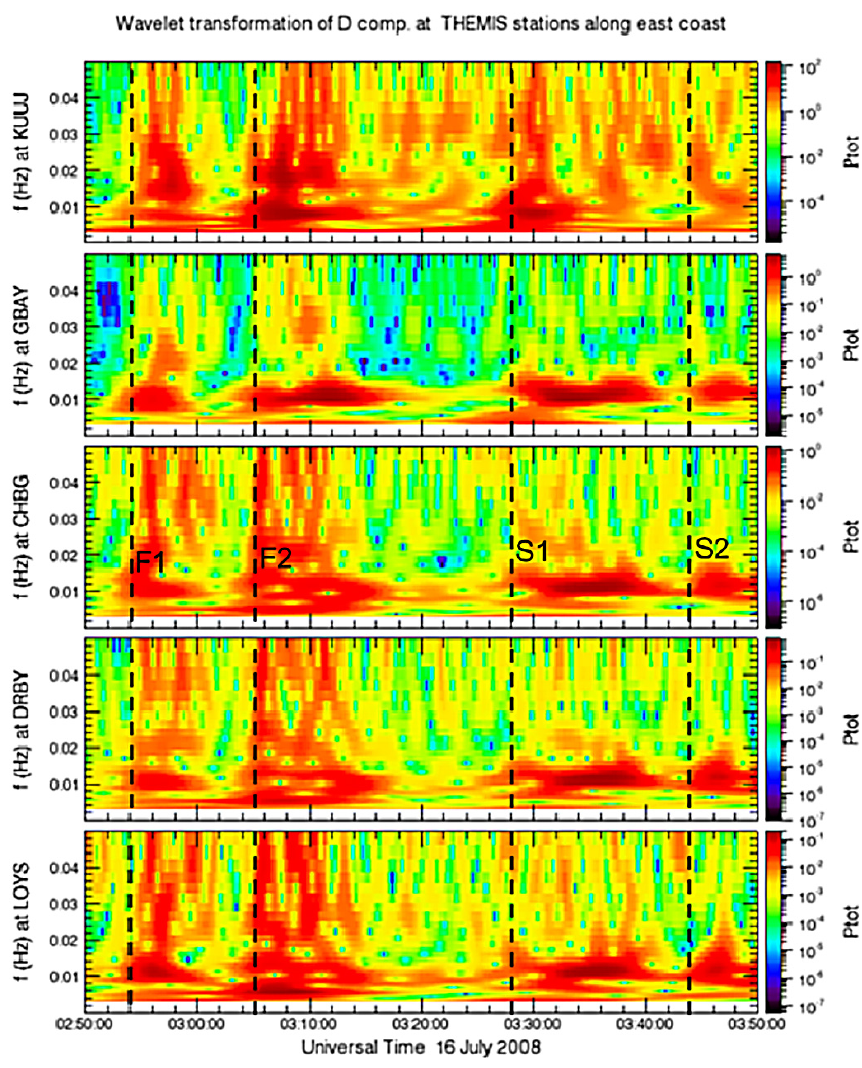
Fig. 5. In the same format as Fig. 4, except for the